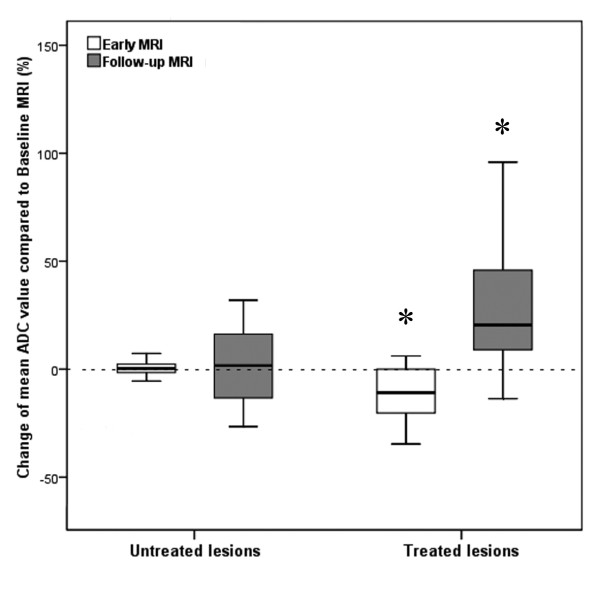
Boxplot depicting changes of mean ADC of non-treated and treated tumors at early and follow-up MRI compared to baseline MRI. Boxplot illustrates changes of mean ADC of non-treated and treated colorectal liver metastases 2 days (early MRI) as well as 3 months (follow-up MRI) following HDR-BT as compared to baseline MRI (*: p < 0.001).